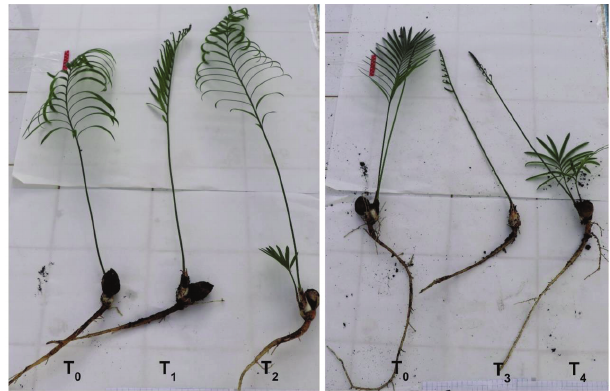
Fig. 5 ­ Cycas revoluta plants obtained from pre­treated seeds with temperature (T1, T2, T3 and T4) and untreated seeds